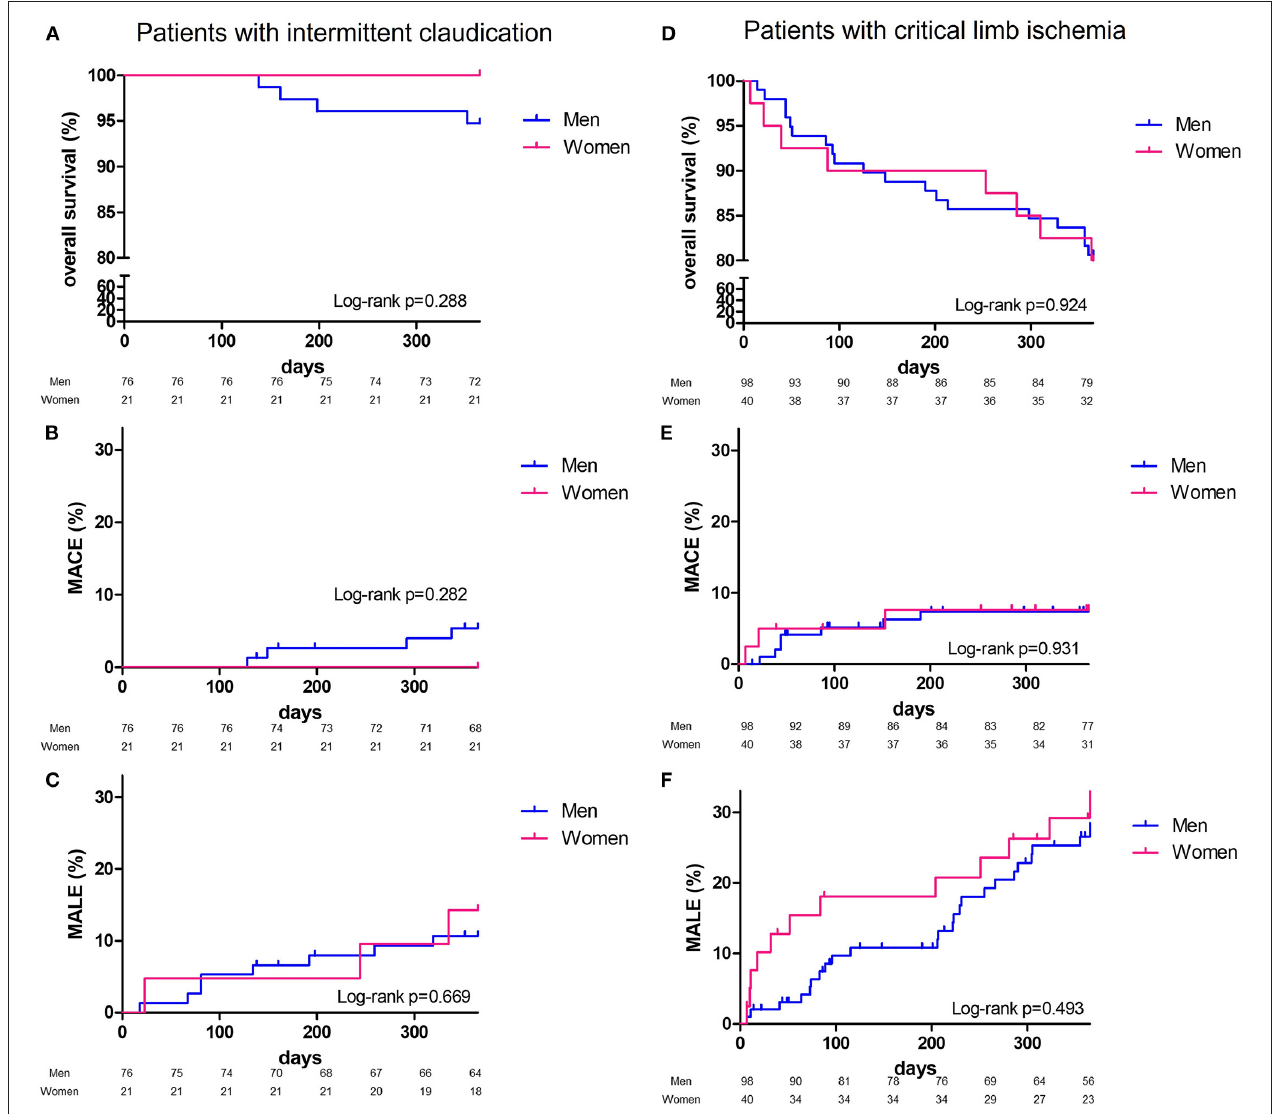
FIGURE 2 | One-year Kaplan-Meier survival curves. Patients with intermittent claudicaion, overall survival (A) , major adverse cardiovascular events: MACE (B) , major adverse limb events: MALE (C) ; patients with critical limb ischemia, overall survival (D) , major adverse cardiovascular events: MACE (E) , major adverse limb events: MALE (F) and comparison according to sex (men, blue line; women, red line) with Log Rank test comparisons between men (blue) and women (red).